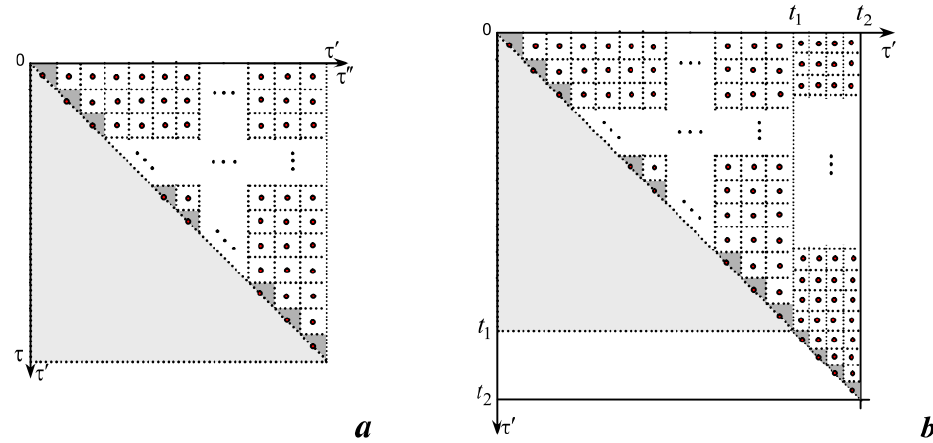
Figure 3. Decomposition of the integration region for fixed τ ( a ) and of the integration region for increasing τ from t 1 to t 2 ( b ).